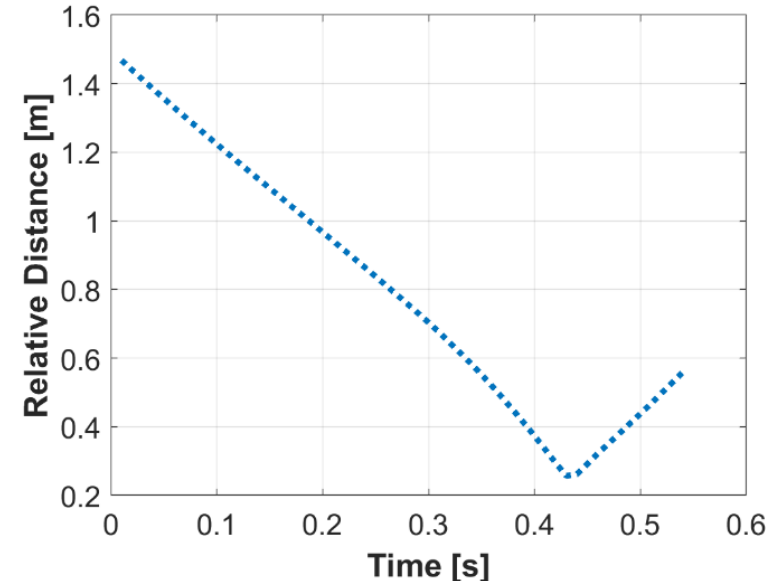
Figure 6. The relative distance between the geometric centre of the ball and the participant’s head. The point of impact between head and ball is clear as the minimum separation distance at time 0.43 s.